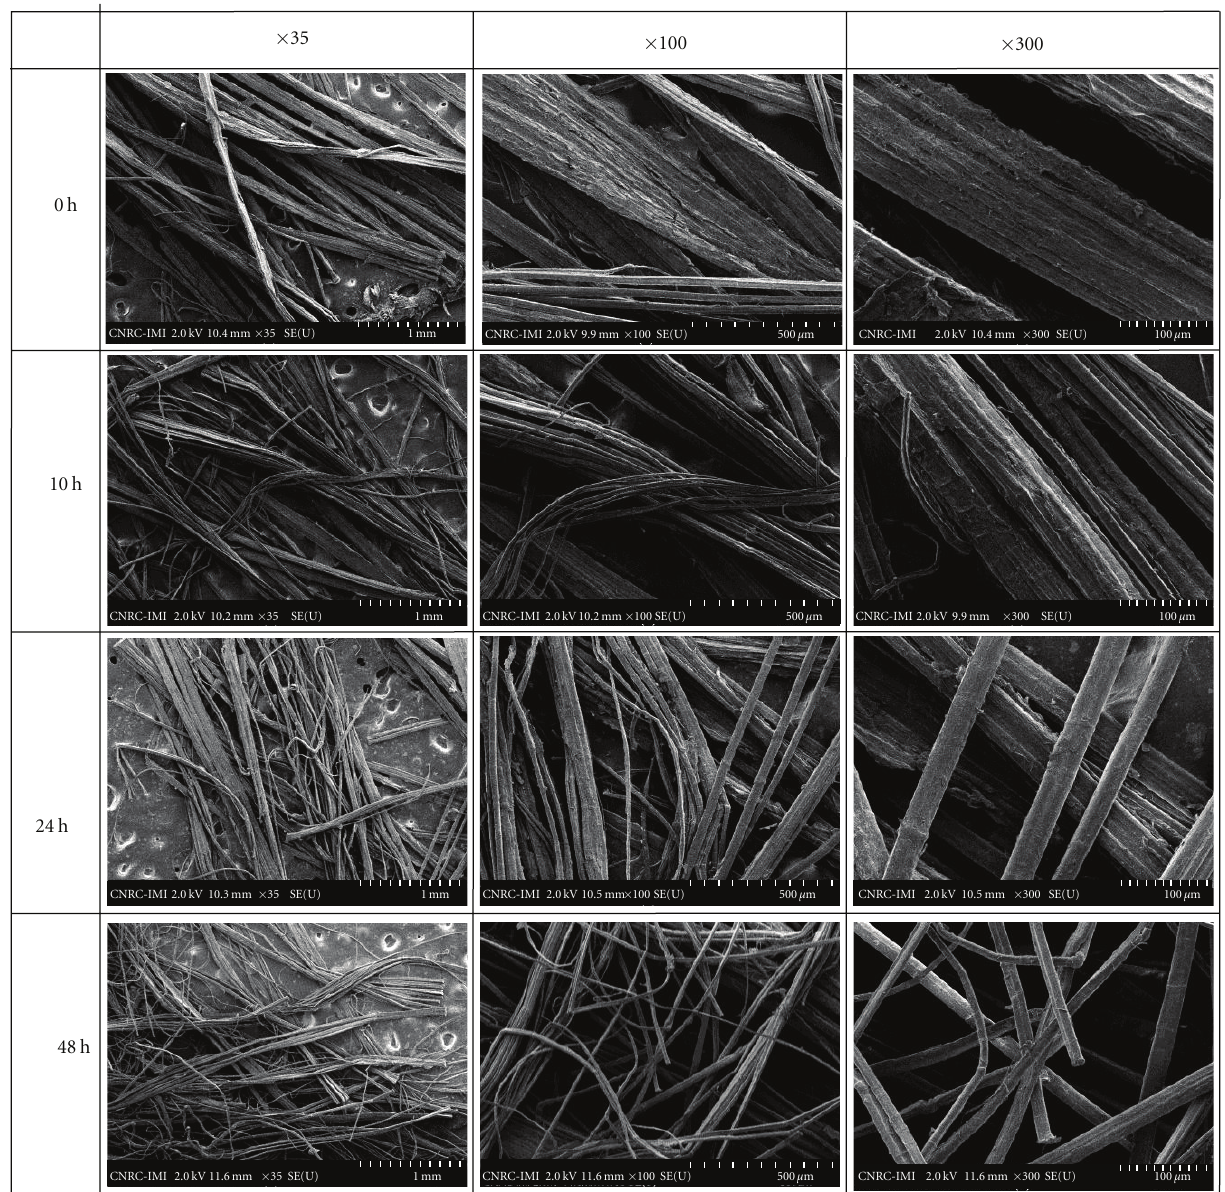
Figure 2: SEM images of fiber samples at di ff erent